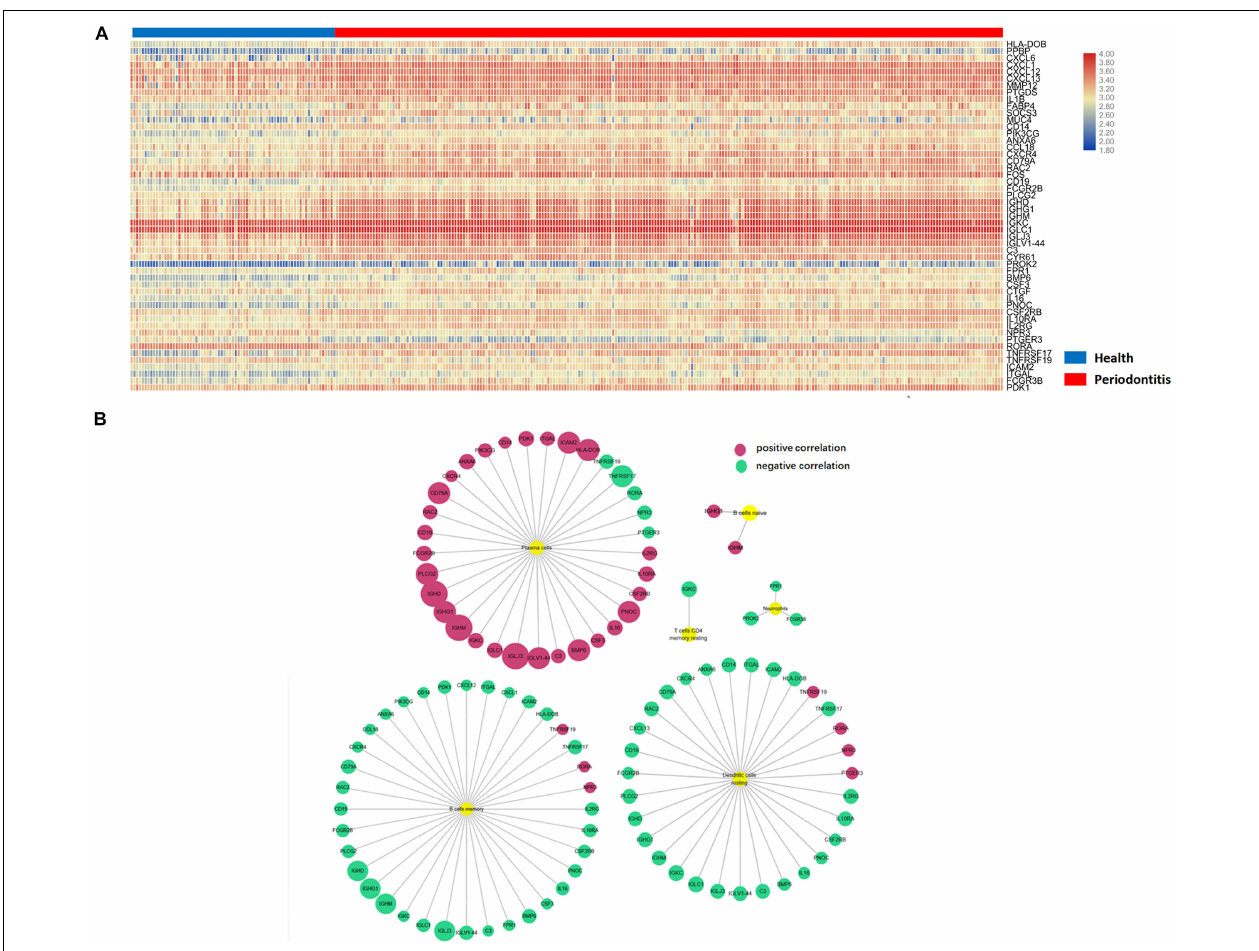
FIGURE 3 | Differentially expressed immune-related genes in immune cells. (A) Differentially expressed immune-related genes in the heatmap. (B) Six immune cell subpopulations significantly correlated with DEMGs, especially for plasma cells, memory B cells and resting